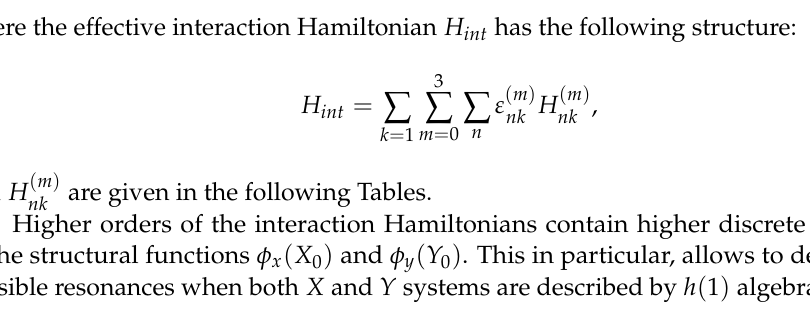
k = 0,1,2 for the parametric quantum oscillator in terms of the small parameter ε = g / ω . Interaction g ef f δω − ( k + 1 ) Ea †2 + h . c